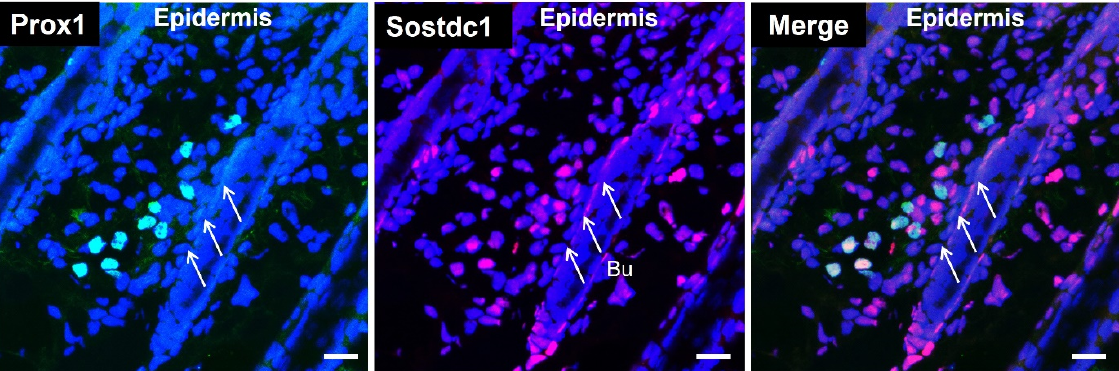
Figure 2. Lymphatic vessels express Sostdc1. Immunofluorescent staining of 10- μ m frozen sections of back skin (anagen phase, postnatal day 8) for Prox1 (lymphatic-specific transcription factor, green) and Sostdc1 (red). Nuclear staining with Hoechst 33342 (blue). White arrows indicate the bulge area (Bu). Scale bars: 20 μ m.